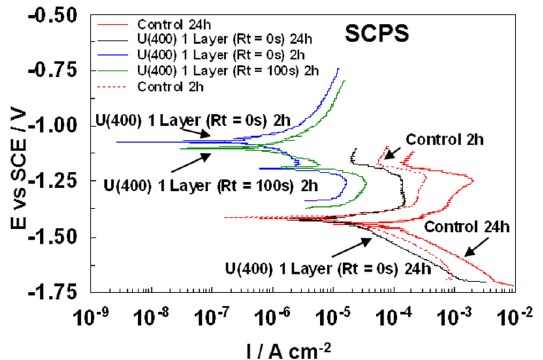
Figure 7. Potentiodynamic polarization curves obtained for HDGS coated with one layer of U(400) with Rt = 0 s and with Rt = 100 s after being immersed in SCPS for 2 h and for 24 h. The curves for uncoated HDGS after being exposed in SCPS for 2 h and 24 h were included for comparison purposes.